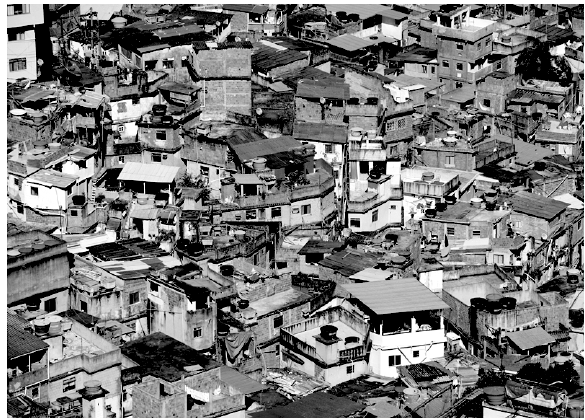
Figure 1. Detail of Rocinha favela housing.